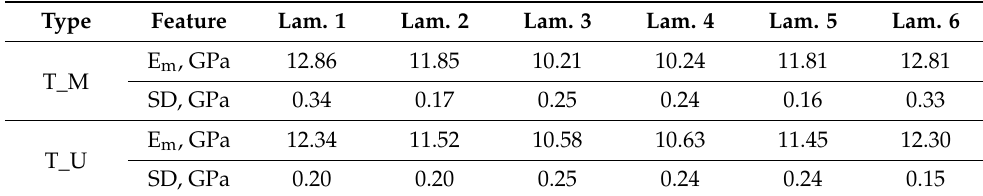
Table 2. Average moduli of elasticity of the lamellas used in the tests for 6-layer beams.